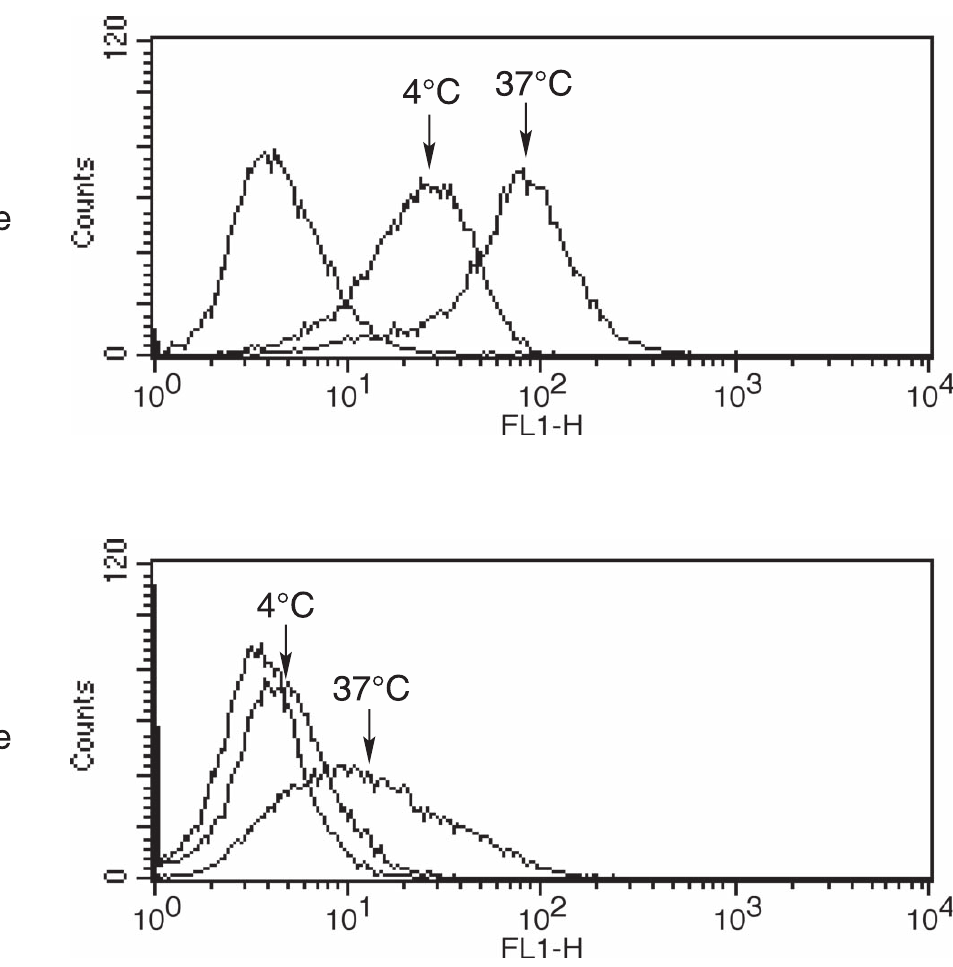
Figure 2. Uptake of liposome-coupled OVA by macrophages. Alexa-labeled OVA was coupled to either stearoyl or oleoyl liposomes and added to the culture of cloned macrophages as described in Materials and Methods. Thirty minutes after the onset of the culture, macrophages were recovered and analyzed using flow cytometry.